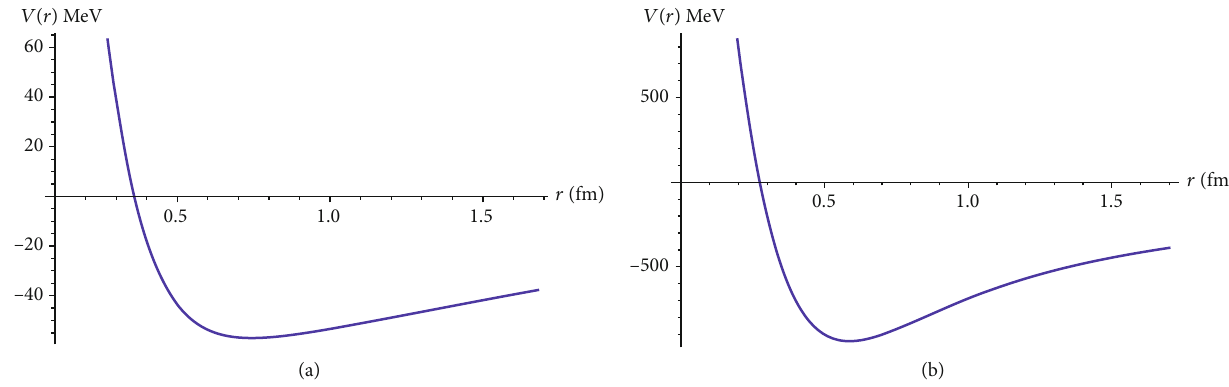
Figure 8: The potential with GY and SPED functions, respectively, of 4 He nucleus as OBEP through the exchange of π , σ , and ω mesons, with parameter